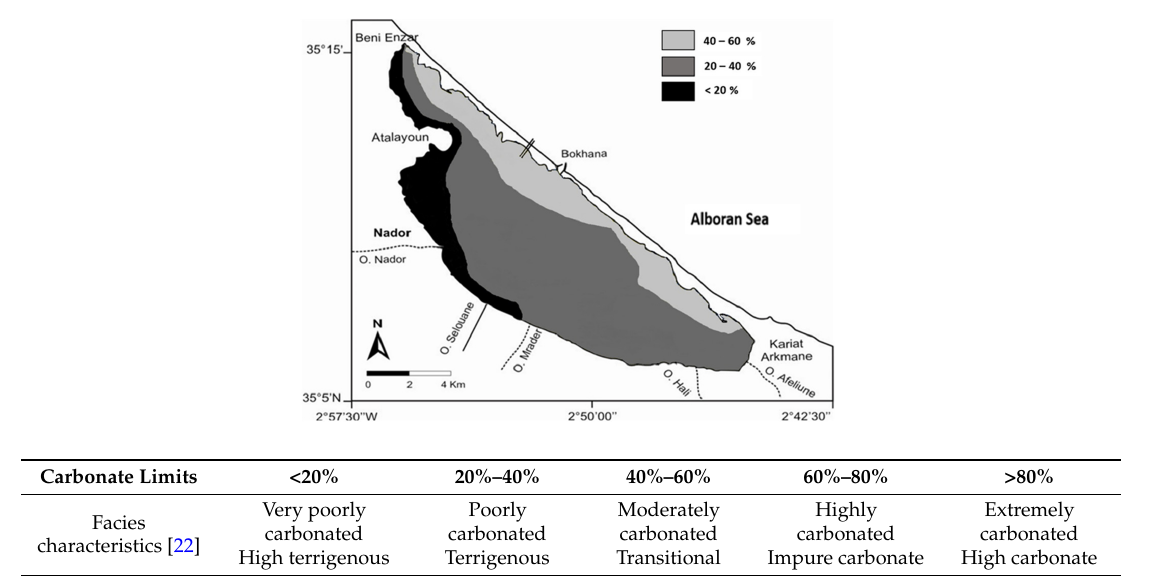
Figure 8. Distribution of carbonate in the seabed surface sediments.